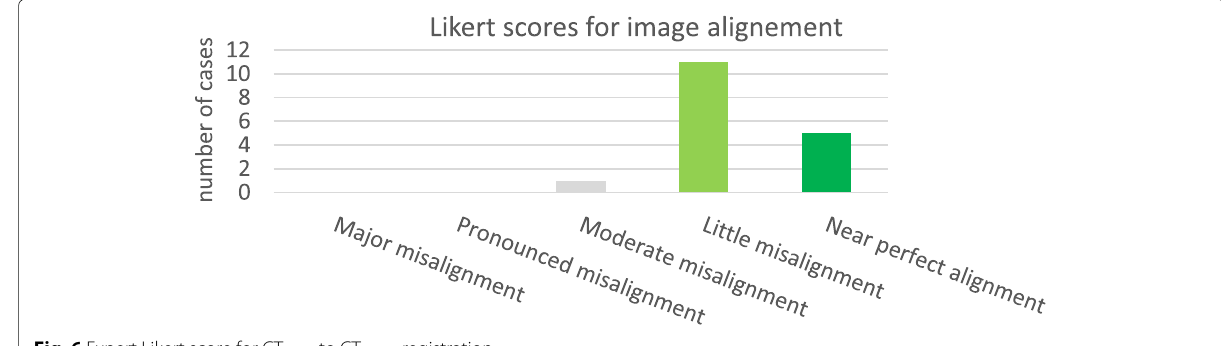
Fig. 6 Expert Likert score for CT FDG to CT MAA